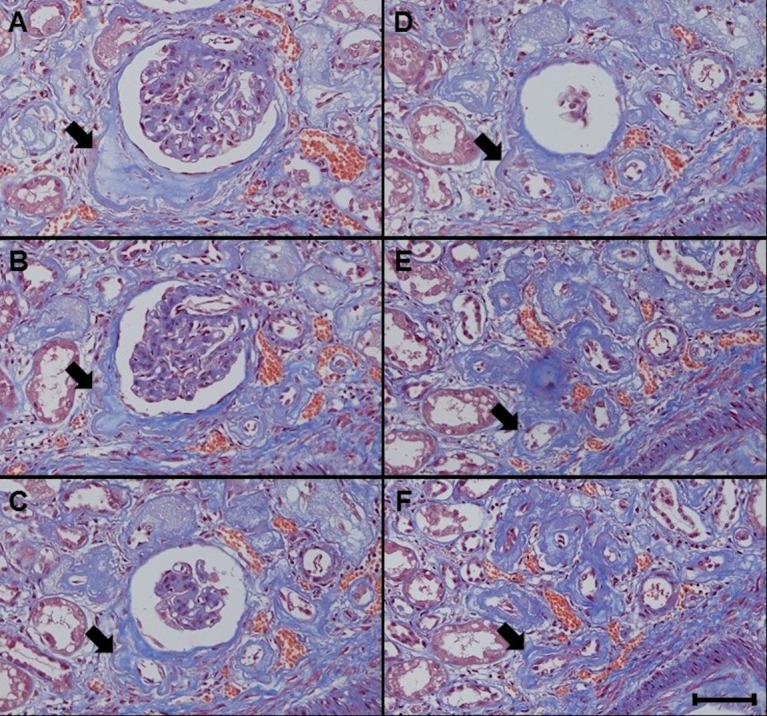
A-F. Paratubular basement membrane insudative lesions (PTBMIL) extending from the glomerulotubular junction to the proximal convoluted tubule. Serial sections revealed that PTBMIL (arrows) developed from the abnormal glomerulotubular junction and extended to the proximal convoluted tubule. Original magnification: x 200. Bar = 100 μm. Masson trichrome stain.